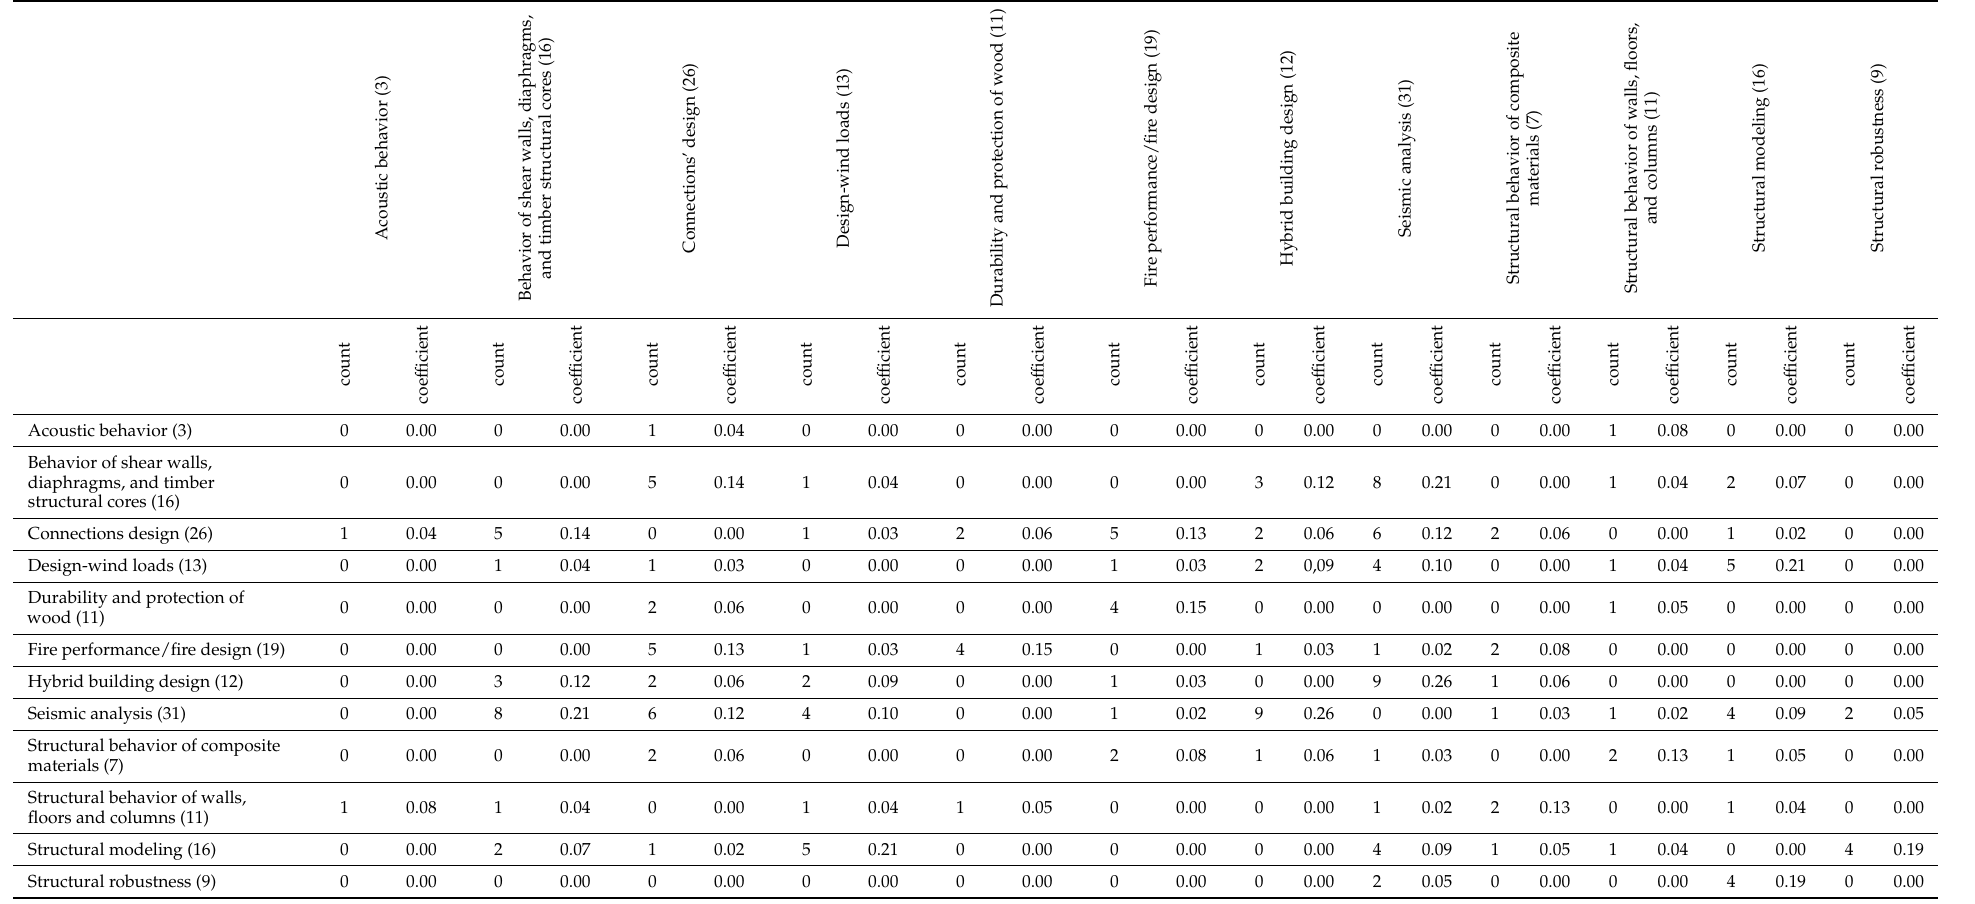
Table 4. Co-occurrences between the findings considered advances in the engineering and construction sciences category, from the review of scientific articles on timber